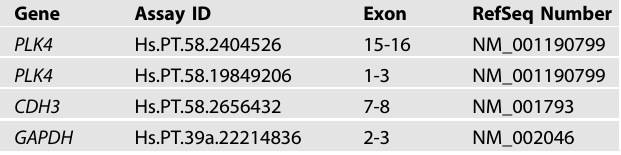
Table 2. List of probes used for